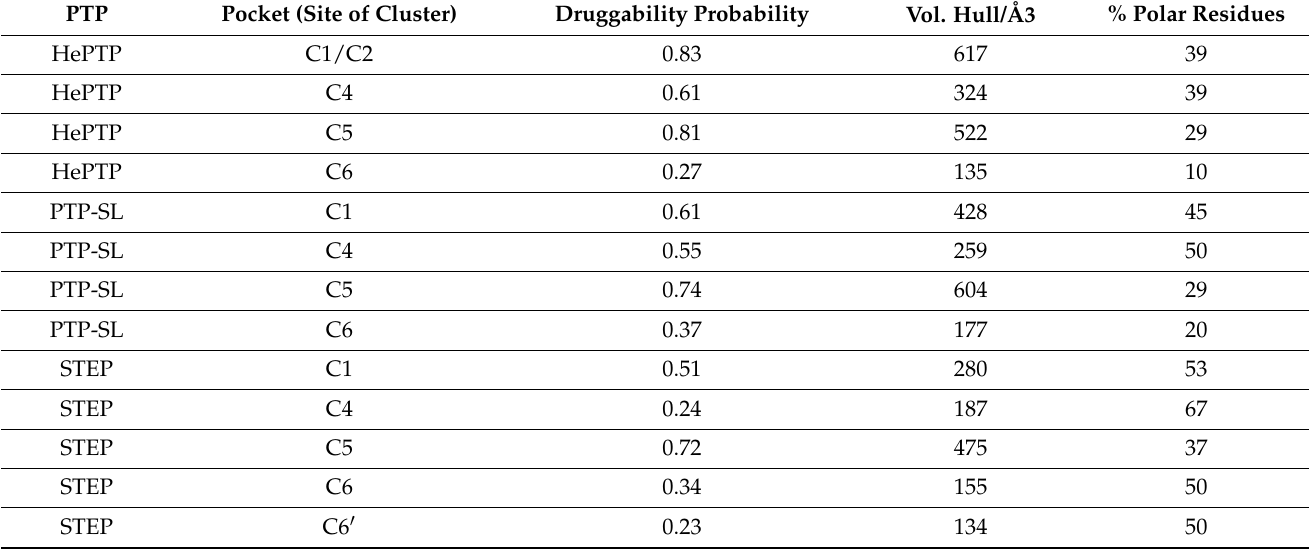
Table 1. Druggability scores calculated by DoGSiteScorer [38] of the pockets associated with clusters 1, 4, 5 and 6 for HePTP, PTPSL and